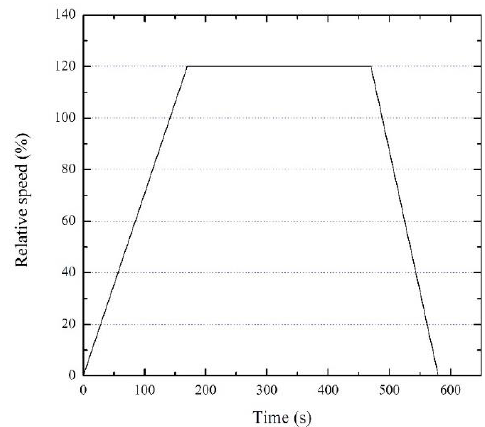
Figure 11. Change in relative speed with time.